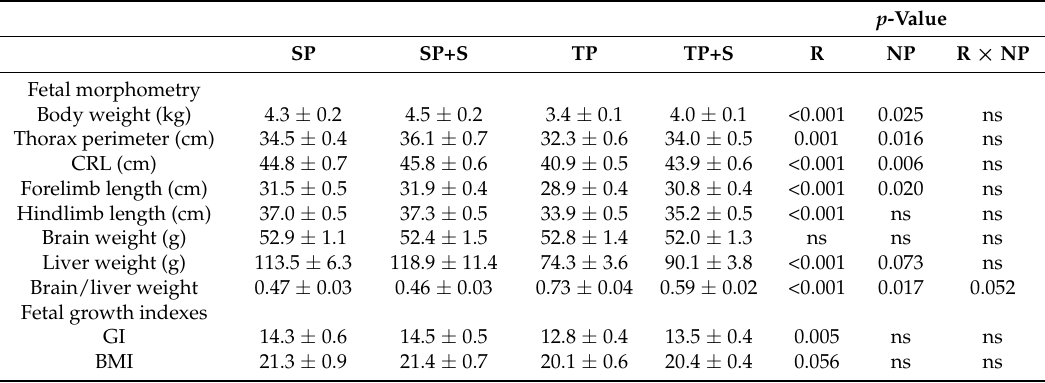
Table 1. Fetal outcomes at 140 days of pregnancy in ewes bearing single and twin fetuses, maintained under adequate or deprived nutritional plane.